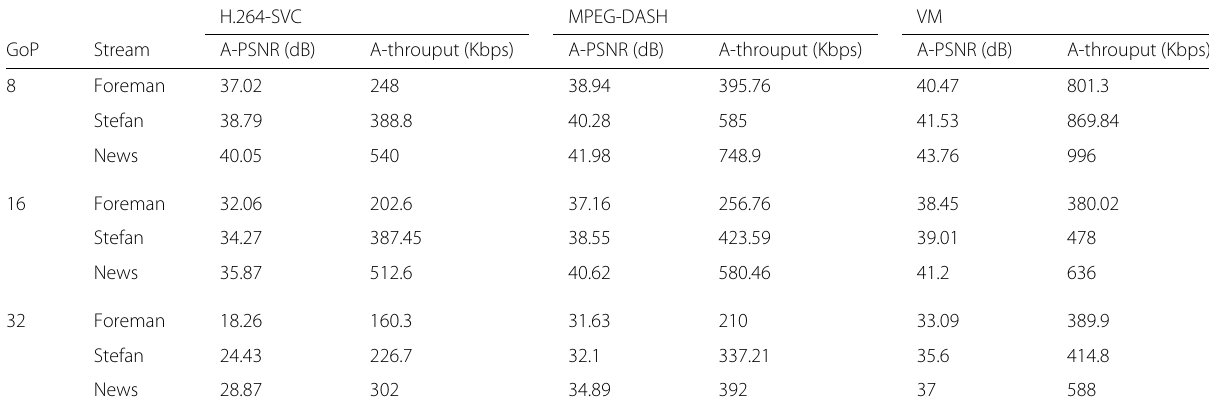
Table 2 Performance comparison with other buffer optimization